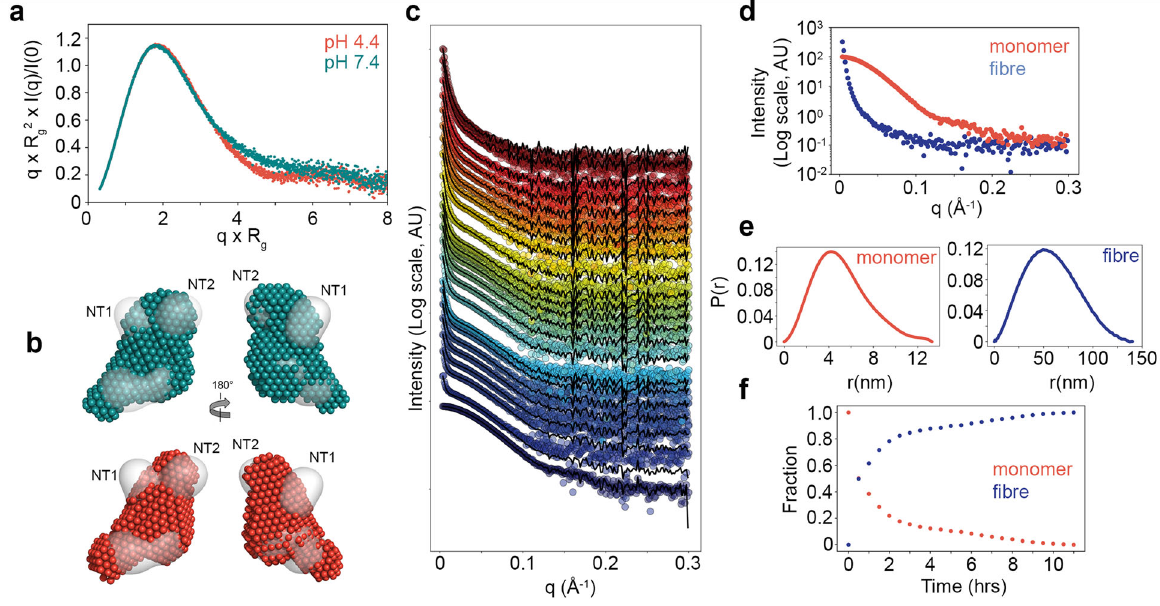
Fig. 4 Kinetics of SslE aggregation. a SAXS normalised Kratky plots for rSslE at pH 4.4 and 7.4. b Overlay of rSslE SAXS bead models at pH 4.4 (red) and 7.4 (teal) with rSslE TEM map (grey). NT1 and NT2 domains are highlighted. c COSMiCS decomposition of the time-dependent rSslE SAXS fi brillation data, assuming that the whole dataset can be described with two co-existing components (monomer and fi bre, panel d ) with different relative populations ( f ). SEC-SAXS curve for rSslE at pH 4.4 (bottom curve) is also shown for t = 0 and used to de fi ne the curve of the monomeric component. Experimental curves are displayed in colour and arbitrarily displaced along the y axis for a better inspection. Black curves are the result of the COSMiCS optimisation. The excellent agreement with the experimental data testi fi es the accuracy of COSMiCS decomposition. e Shape distribution ( P(r) ) functions derived from COSMiCS decomposed scattering curves for rSslE monomer (red) and aggregates (blue). f Relative populations of the two species of rSslE derived from the COSMiCS analysis over (Fig. 4f), we discarded the low q region and used this data to carry out analysis of the fi bre asymmetric unit. Geometrical shape analysis suggested that rSslE fi bres form a cylinder with a radius 3.2 nm and height 16.5 nm, and cross-sectional analysis indicated a repetitive unit with a cross-sectional R g ( R c ) of 4.78 nm. The cross-sectional P ( r ) C gave a cross-sectional D max of 14.0 nm. clustered rSslE fi bres derived from negative-stain TEM and MALS.